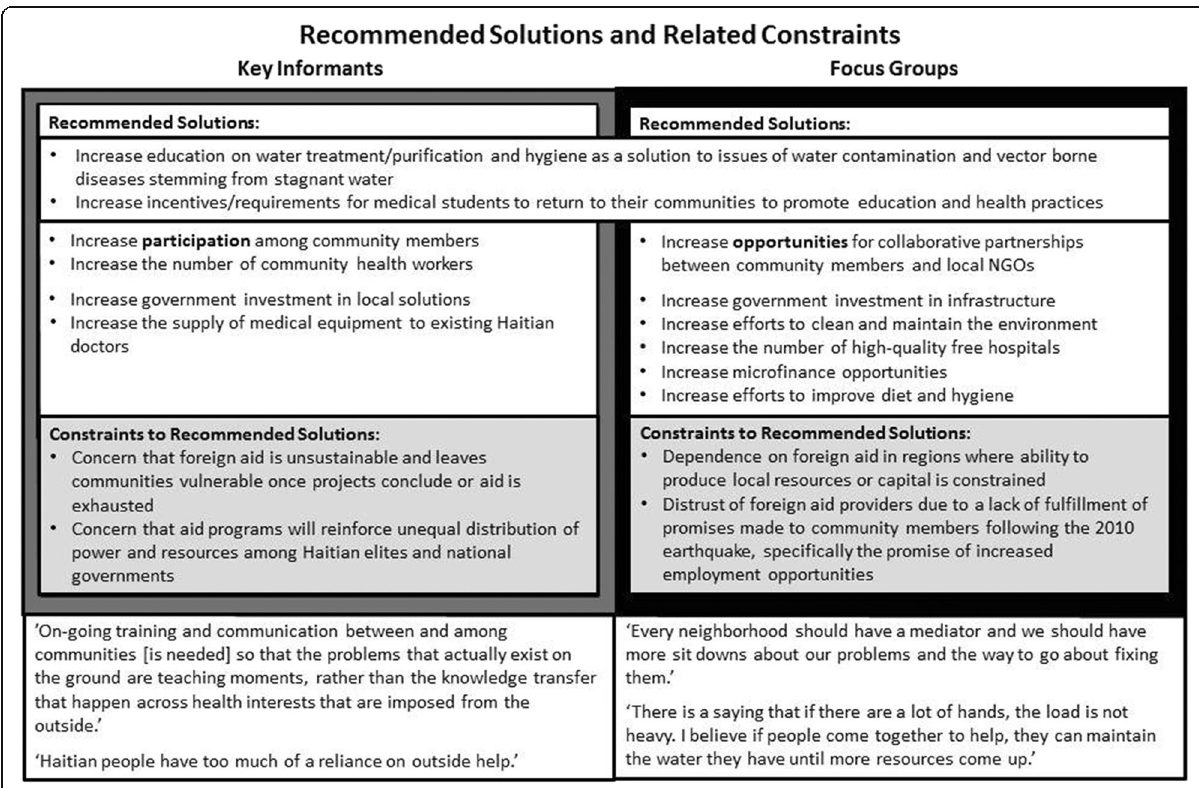
Fig. 1 Recommended solutions and related constraints across key informant interviews and focus